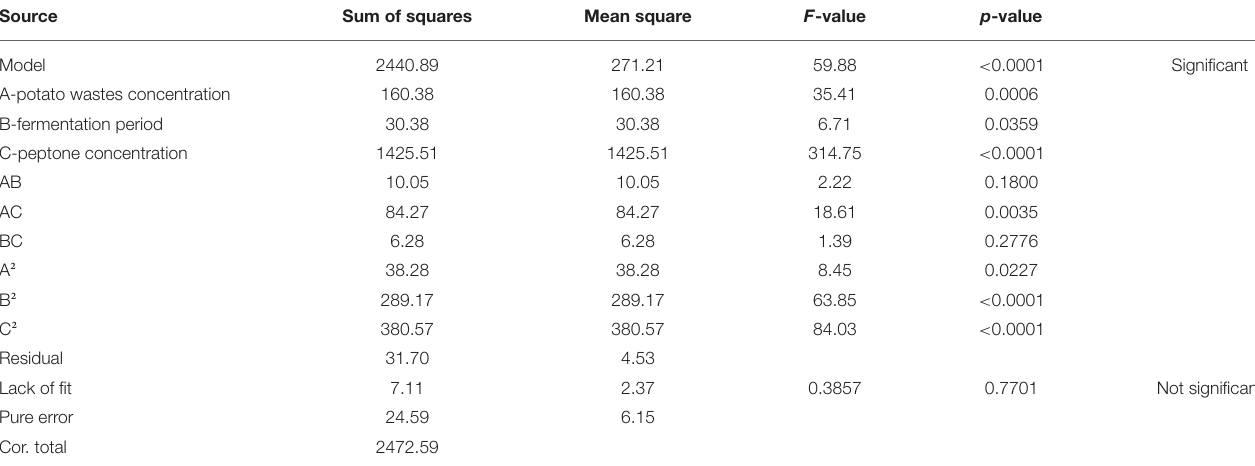
TABLE 4 | ANOVA for the entire quadratic model of response (1) concentration of total pigment.